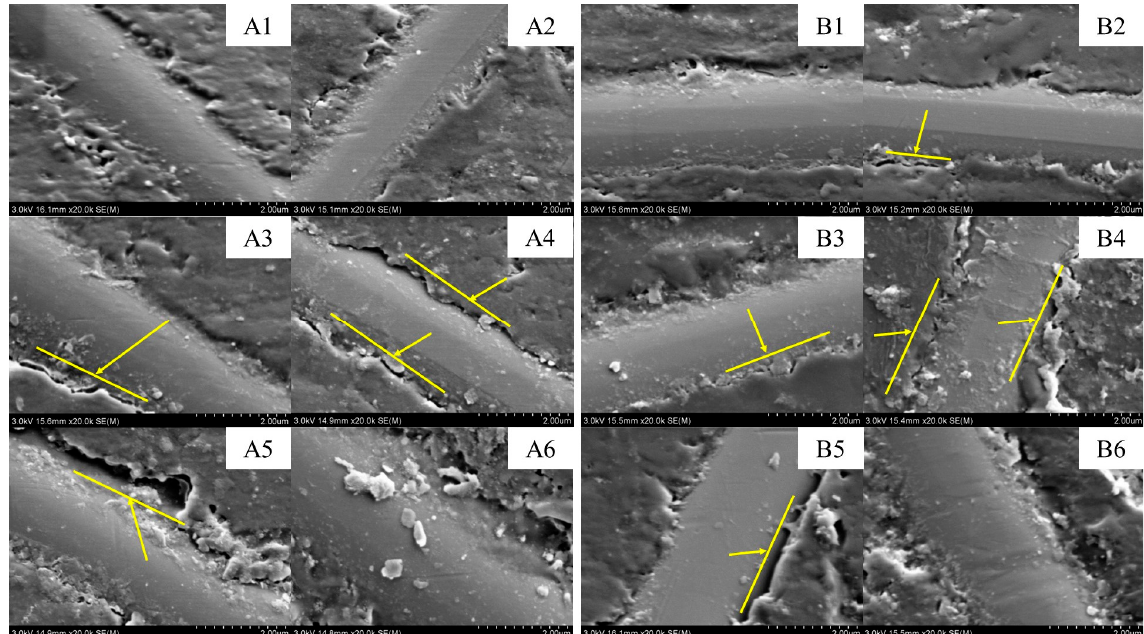
Figure 13. SEM images (at 20k× magnification) of the surface morphology of the epoxy pultruded composites before and after ageing (( A1 – A6 ) hygrothermal ageing, ( A1 ) 0 h, ( A2 ) 240 h, ( A3 ) 960 h, ( A4 ) 2160 h, ( A5 ) 3120 h, and ( A6 ) 5280 h; ( B1 – B6 ) salt mist ageing, ( B1 ) 0 h, ( B2 ) 240 h, ( B3 ) 960 h, ( B4 ) 2160 h, ( B5 ) 3120 h, and ( B6 ) 5280 h).